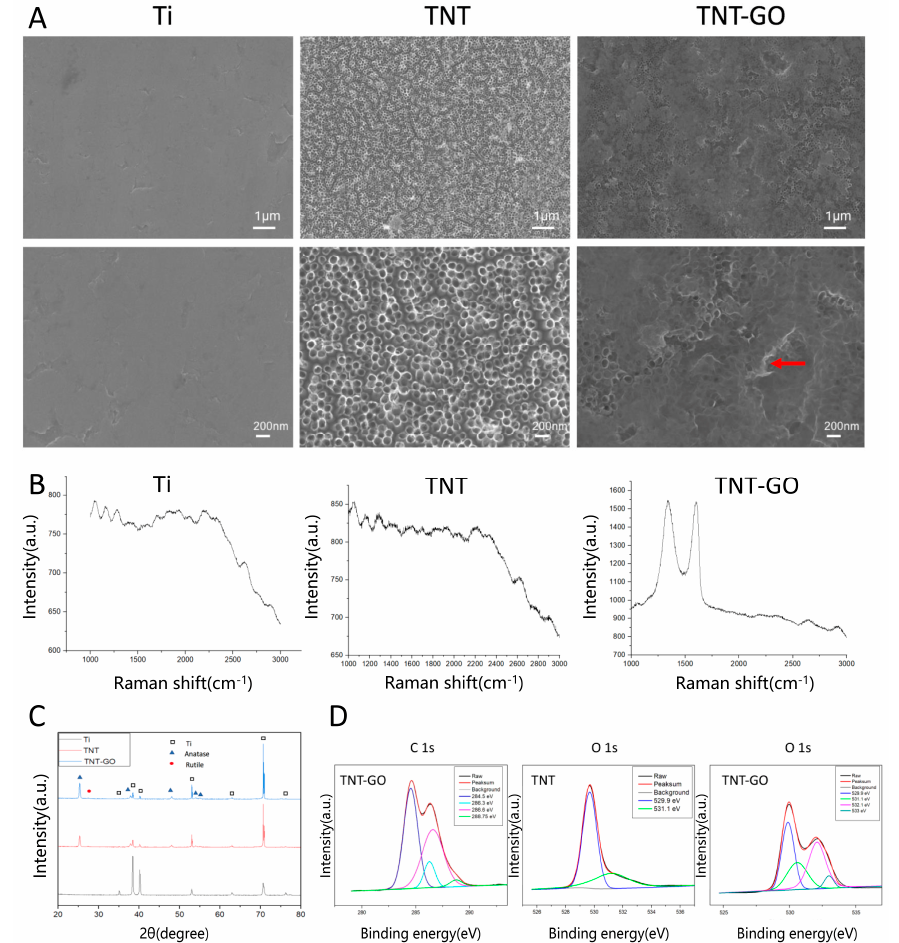
Figure 1. Results of surface characterization of the Ti, TNT, and TNT-GO samples. ( A ) SEM images; ( B ) Raman spectra; ( C ) XRD patterns; ( D ) High—resolution XPS spectra of C 1s and O 1s. Abbrevia- tions: Ti, pure titanium; TNT, TiO 2 nanotubes; TNT-GO, TiO 2 nanotubes with graphene oxide; XRD, X-ray diffraction; XPS, X-ray photoelectron spectroscopy. GO film was marked by red